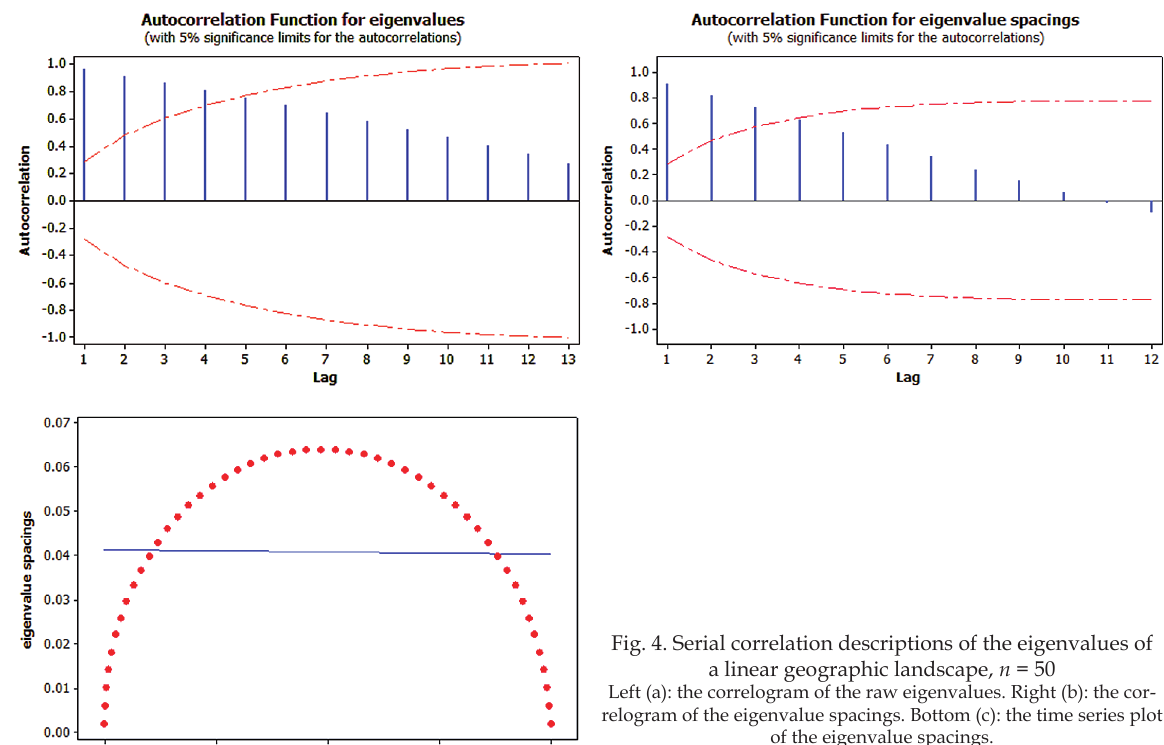
Fig. 4. Serial correlation descriptions of the eigenvalues of a linear geographic landscape, n = 50 Left (a): the correlogram of the raw eigenvalues. Right (b): the cor - relogram of the eigenvalue spacings. Bottom (c): the time series plot of the eigenvalue